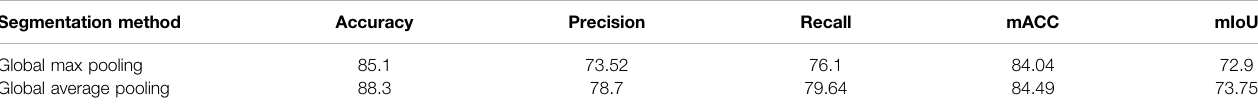
TABLE 6 | Ablation studies of the cross fusion module. The global max pooling (GMP) and global average pooling (GAP) denote the different implementation of the cross fusion module on the class fusion branch. Segmentation method Global max